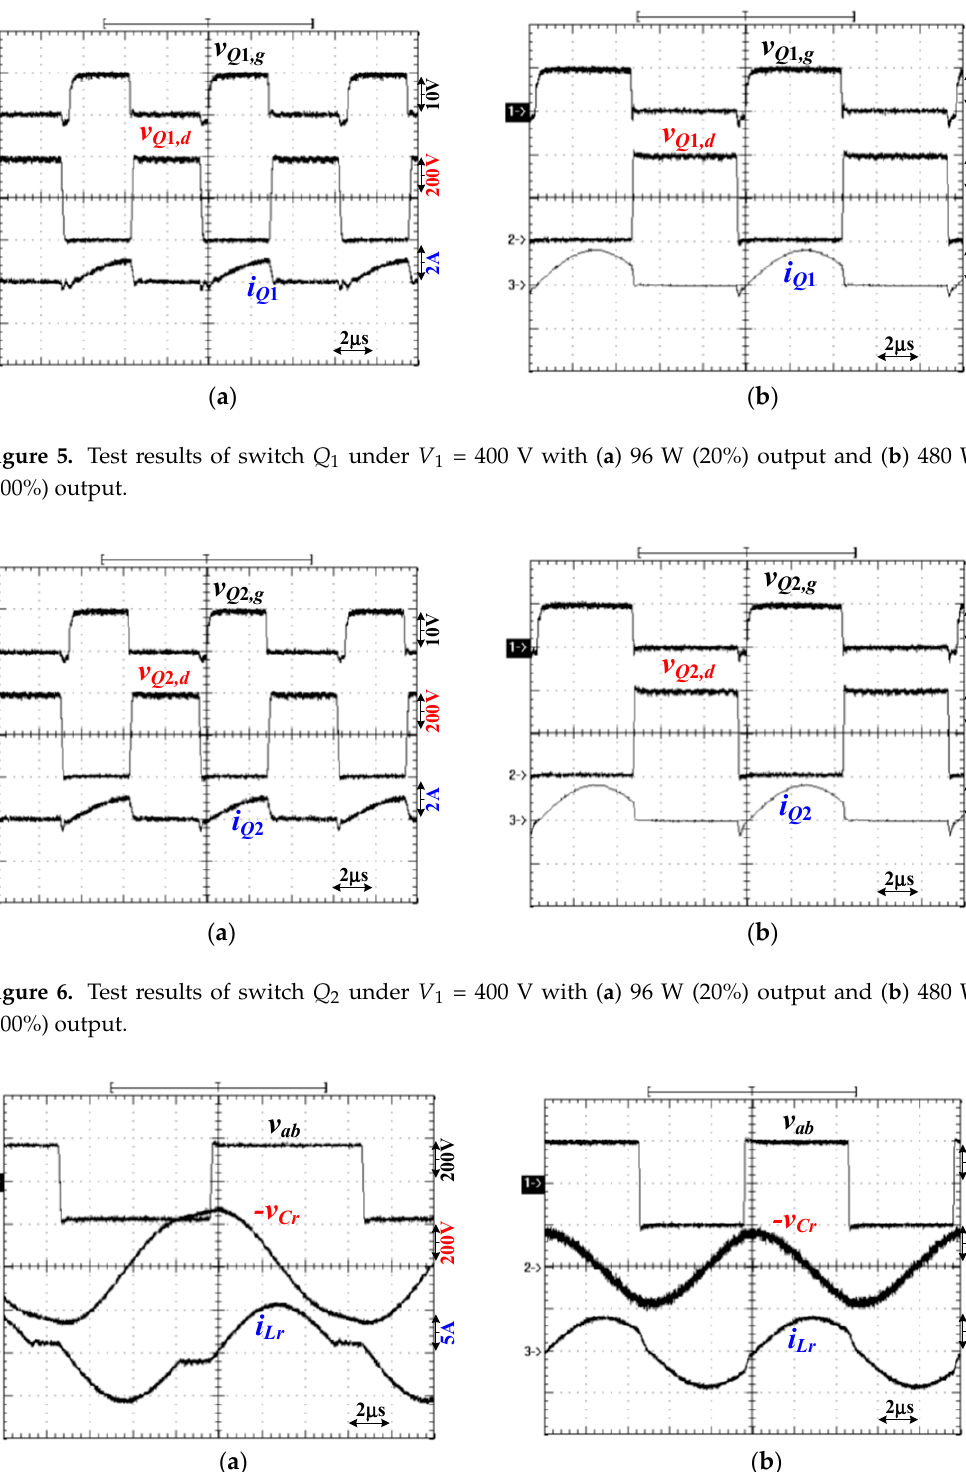
Figure 7. Test results of v ab , − v Cr , and i Lr under 480 W output with ( a ) V 1 = 350 V and ( b ) V 1 = 400 V.